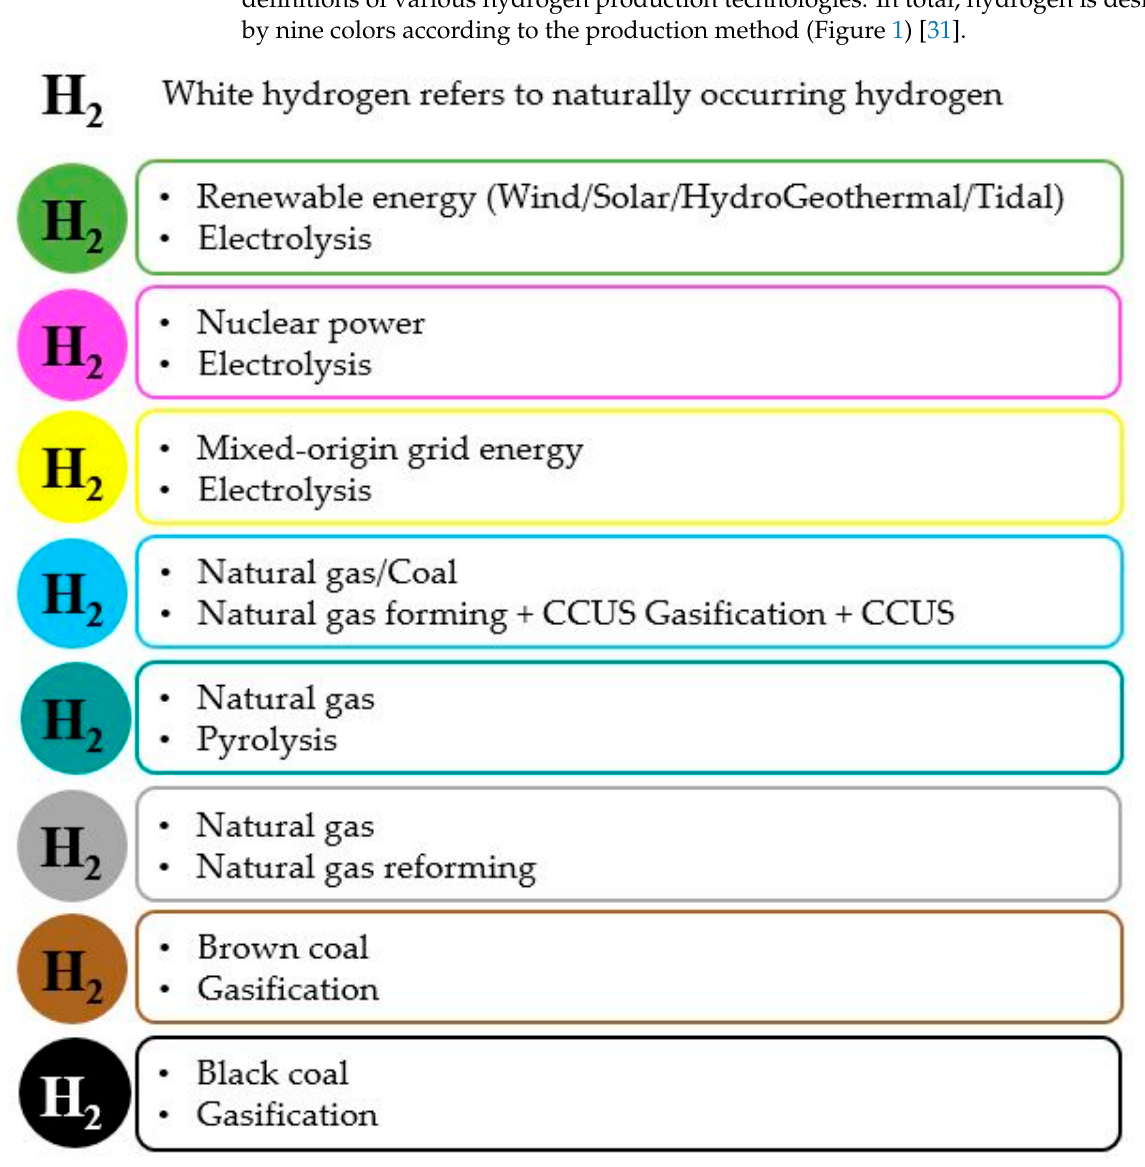
Figure 1. Hydrogen color spectrum [31].